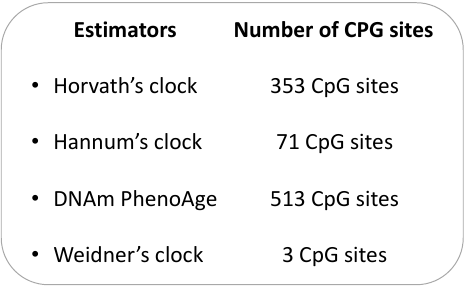
Figure 1. The most common DNA methylation-based biological aging estimators.